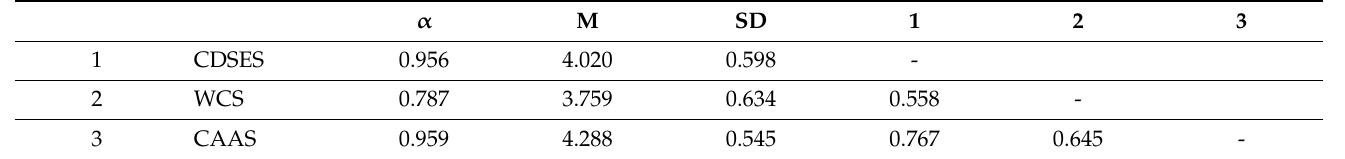
Table 2. Means, standard deviations, α s, and correlations of willingness to compromise, career decision self-efficacy, and career adaptability.